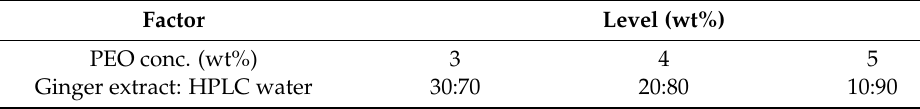
Table 1. Design of the experiment (DOE).